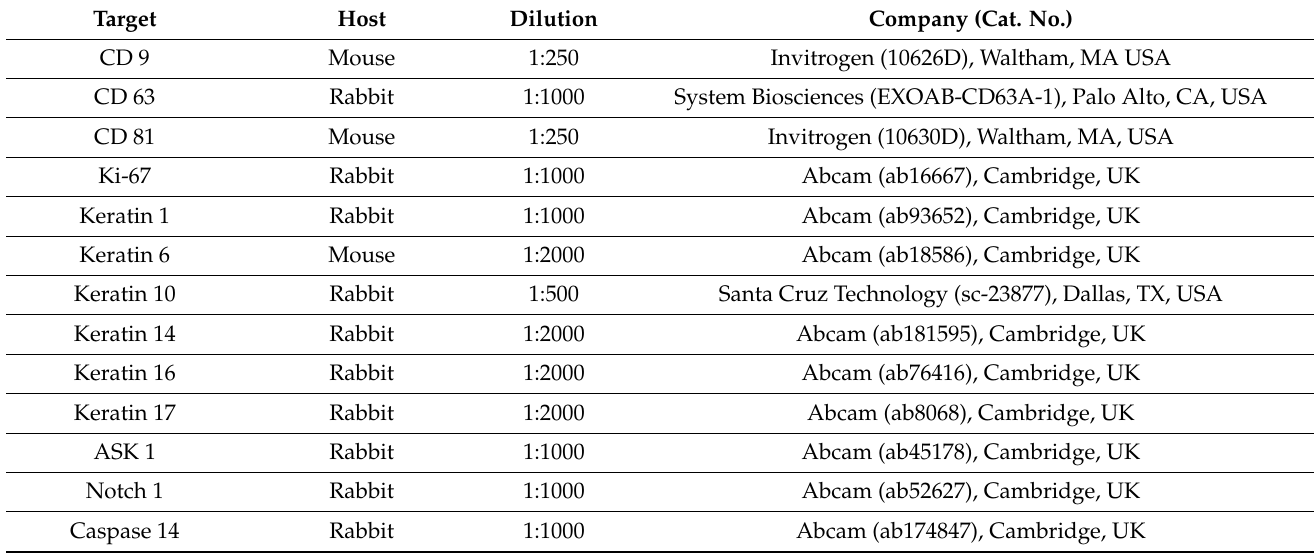
Table 2. Primary antibodies used in Western blot